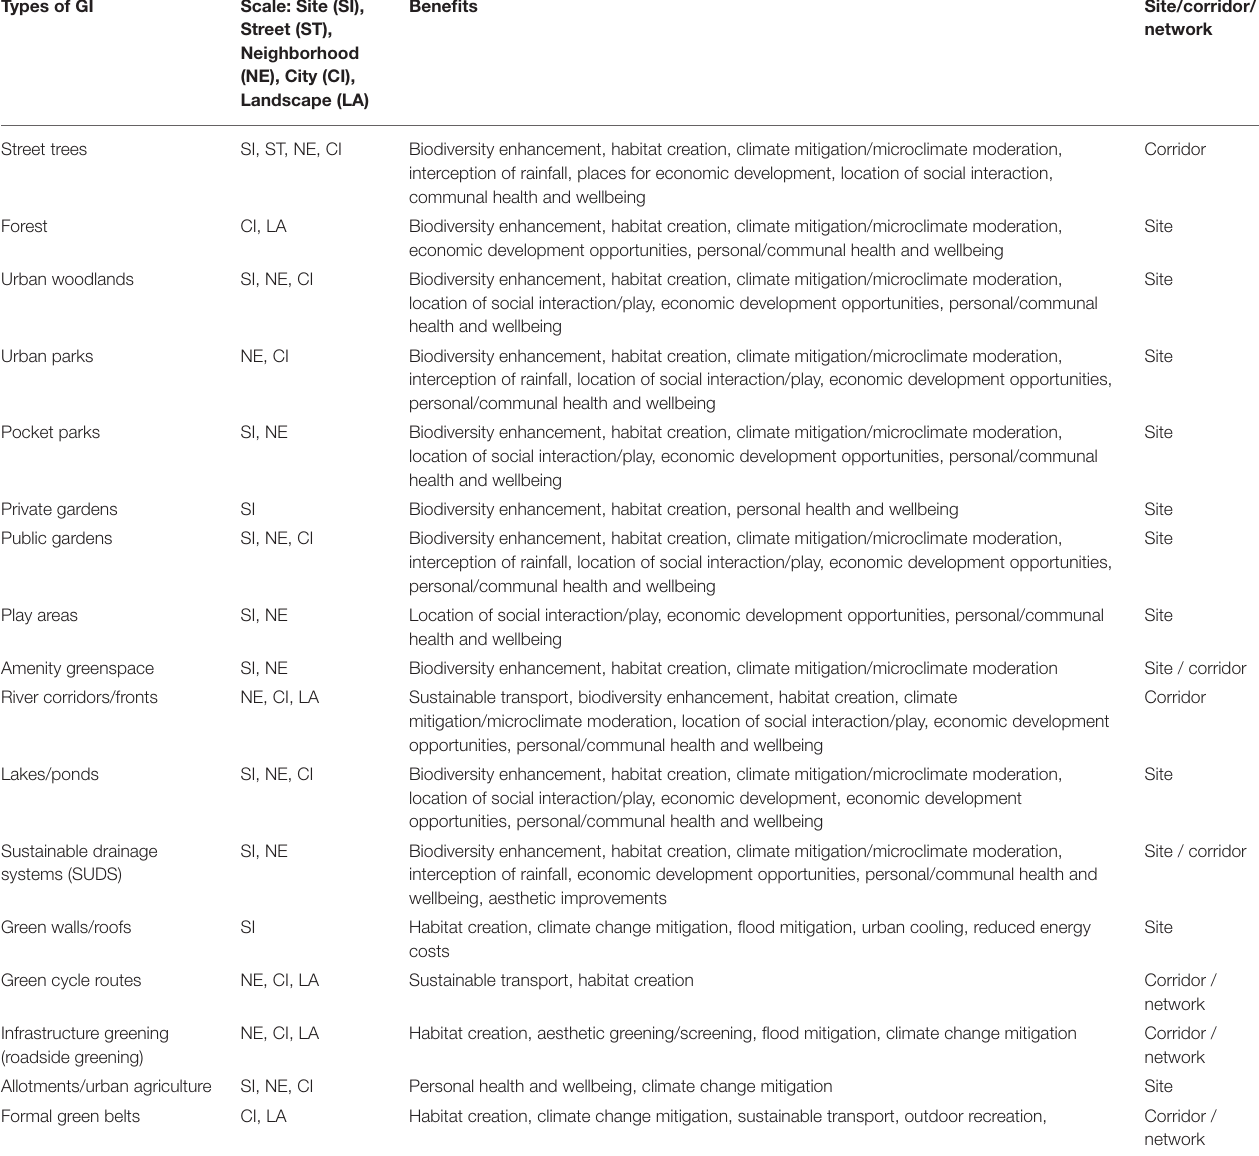
TABLE 1 | Common GI typologies (adapted from Mell and Whitten,